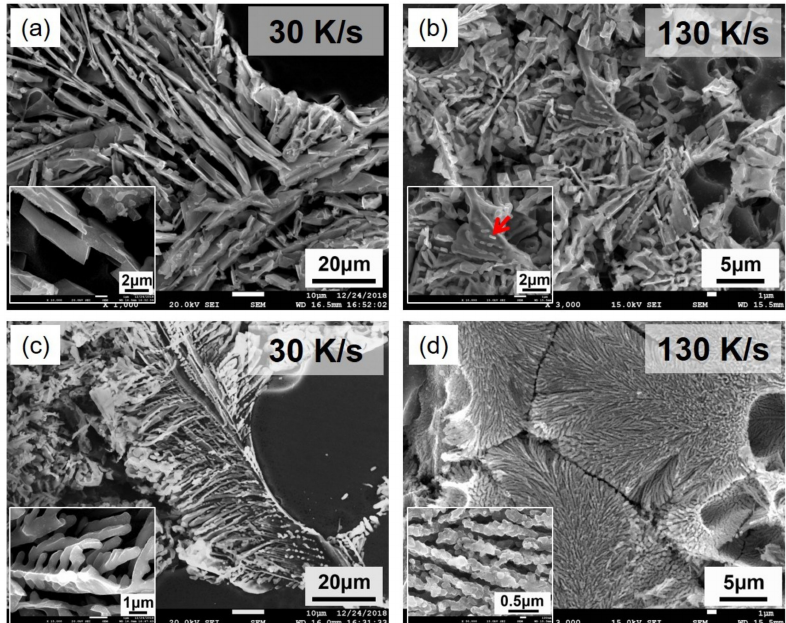
Figure 11. 3D morphology of eutectic Si in ( a , b ) Al7SiMg and ( c , d ) Al7SiMg + 0.4La alloys at the cooling rate of 30 and 130 K / s.